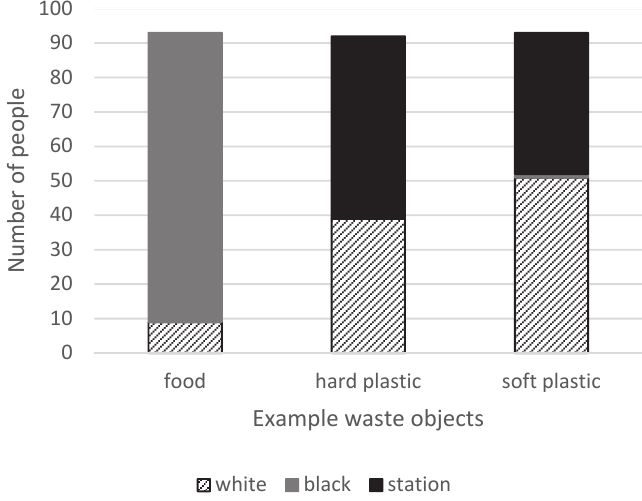
Figure A21. Waste sorting behavior by giving examples, second survey (93 individuals).